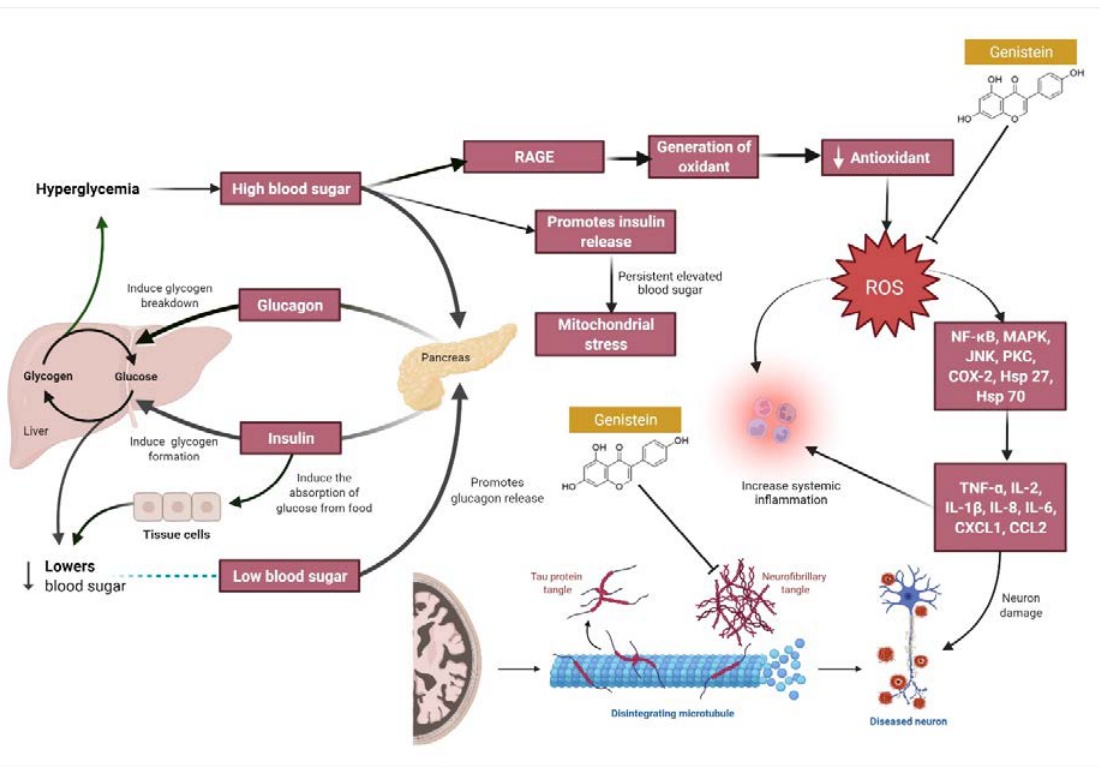
Figure 4. Hyperglycemia and its consequences to neurons. Hyperglycemia produces systemic inflammation and continuous cycles of oxidative and mitochondrial stress, as well as activates multiple downstream kinases that drive a cascade of cytokine and chemokine release, producing additional neuronal damage. Genistein aids in the inhibition of reactive oxygen species (ROS) and the aggregation of Tau protein tangles, minimising the risk of neuronal injury. Abbreviations: NF- κβ , Nuclear factor kappa light chain enhancer of activated B cells; MAPK, Mitogen-activated protein kinase; JNK, c-Jun N-terminal kinase, PKC, Protein kinase C; ROS, Reactive oxygen species,; COX- 2, Cyclooxygenase-2; Hsp 27 & 70, Heat shock protein 27 & 70; TNF- α, Tumour necrosis factor alpha; IL- 2, 1β, 8 & 6, Interleukin -2, 1 beta, 8 & 6; CXCL1, C-X-C motif chemokine ligand 1; CCL, C-C motif chemokine ligand 2.